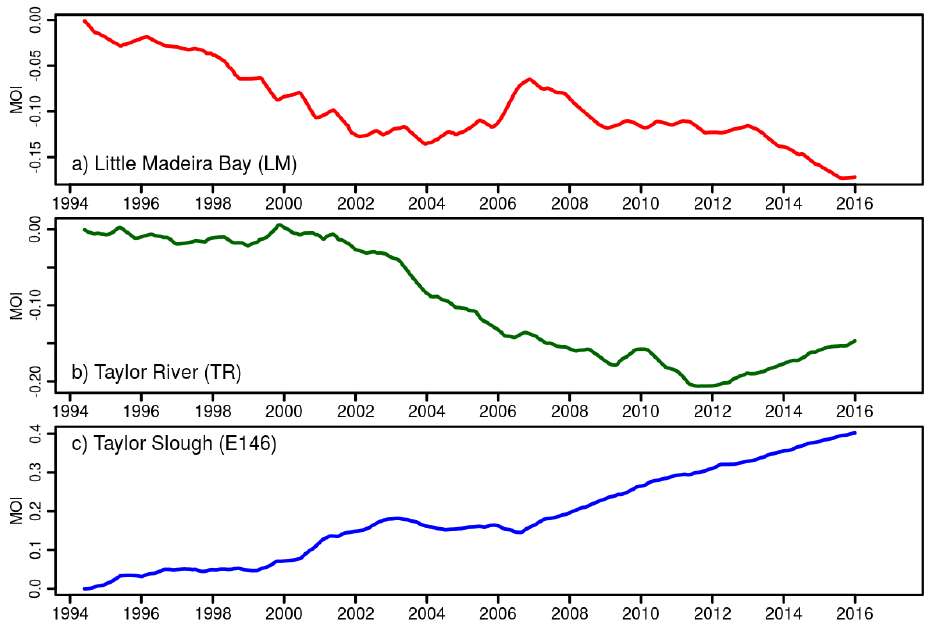
Figure 14. Integral over time of the Marsh-to-Ocean Index (MOI) at: ( a ) Little Madeira Bay (LM); ( b ) Taylor River (TR); and ( c ) Taylor Slough